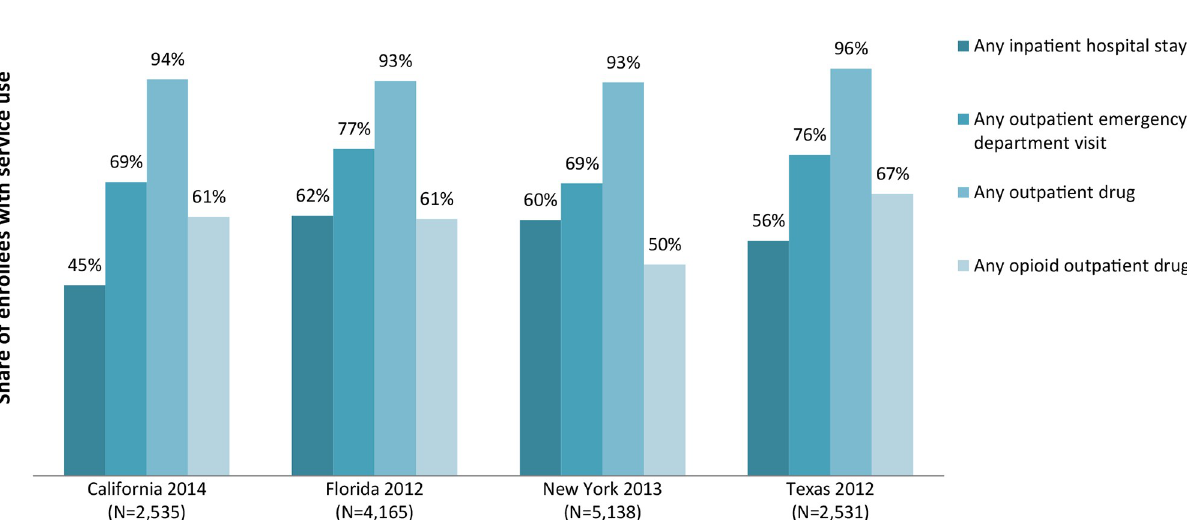
PLOS ONE | https://doi.org/10.1371/journal.pone.0257796 October 27,